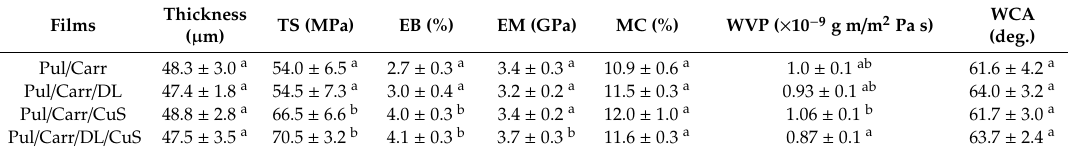
Table 2. Mechanical properties, WVP, WCA, and MC of pullulan / carrageenan-based films.